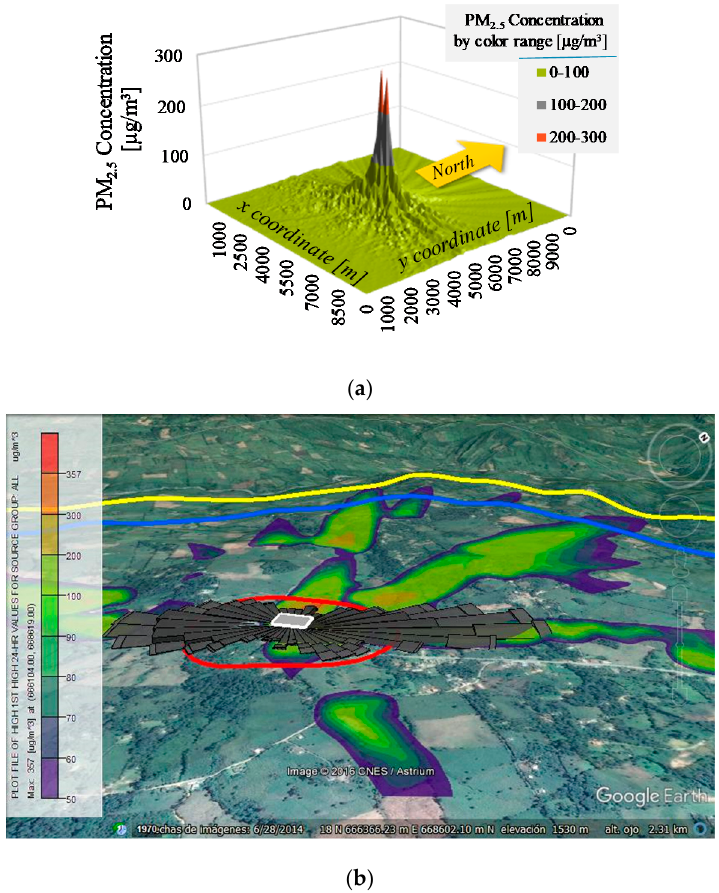
Figure 4. PM 2.5 ground concentration over a 10 km × 10 km region as result of the sugarcane burning on a square area of 1 ha at a burning rate of 18.6 g/s: ( a ) 3D representation of PM 2.5 concentration; and ( b ) 2D representation of PM 2.5 concentration. The lines in ( b ) represent circumferences centered in the emission source that limit the obtained influence area when the threshold value is 50 μ g/m 3 (yellow), 100 μ g/m 3 (blue) and 300 μ g/m 3 (red).